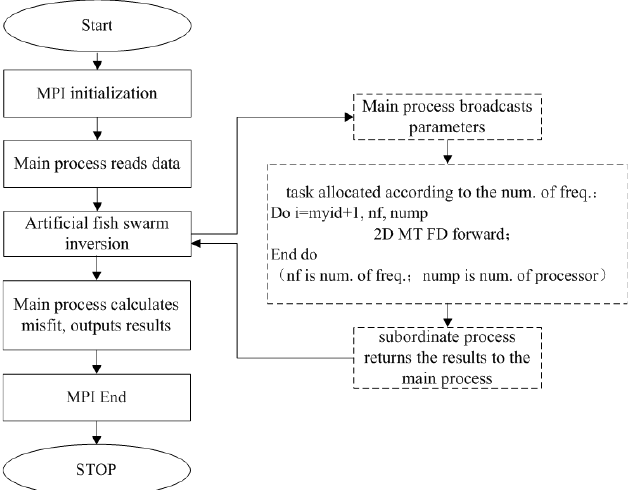
Figure 5. Brief diagram of 2D MT parallel-constrained-inversion for the artificial fish-swarm.